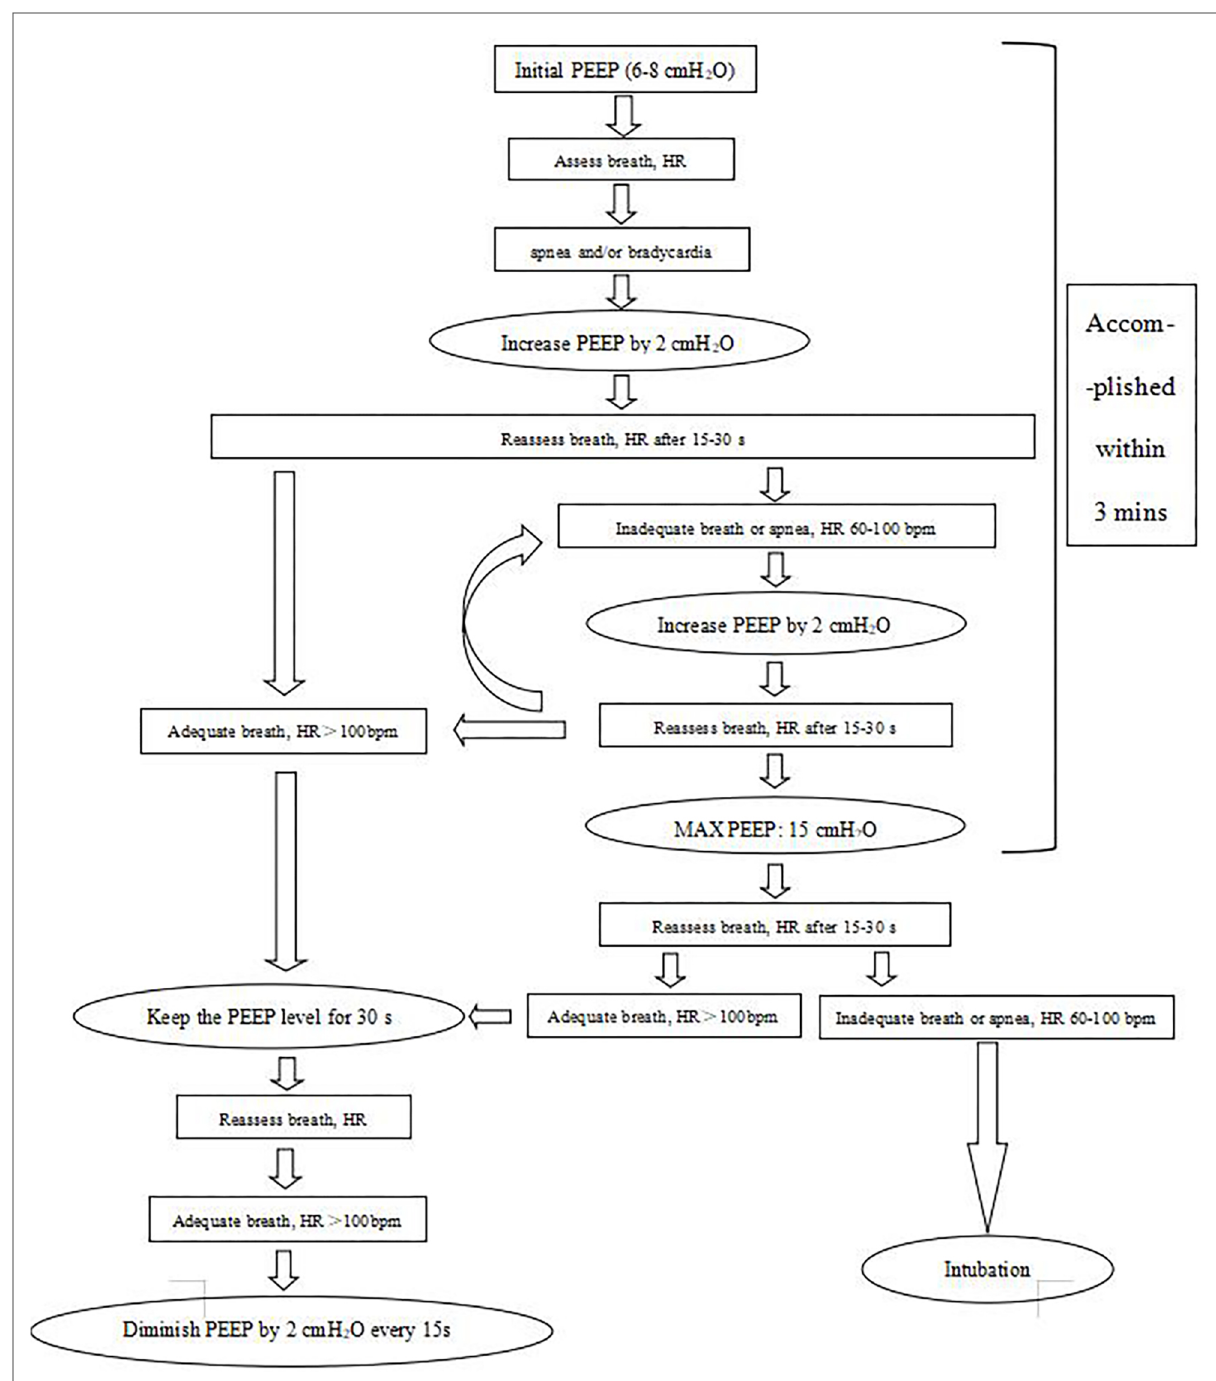
FIGURE 1 The dynPEEP algorithms in DR